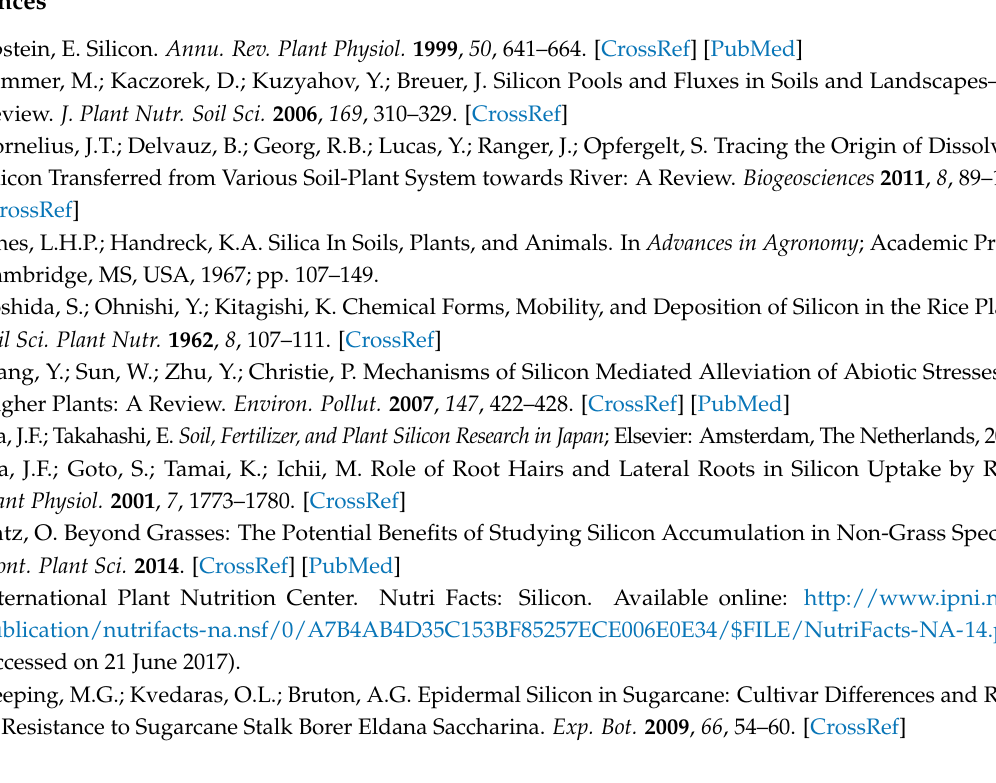
Figure A2. Interactive effects of Dermacor treatment and variety on whitehead densities in 2013, 2014, and 2015. Parallel lines indicate absence of interaction ( P > 0.05), while lines with different slopes (non-parallel lines) indicate presence of interaction ( P < 0.05). Figures 2014 and 2015 show significant interactions.